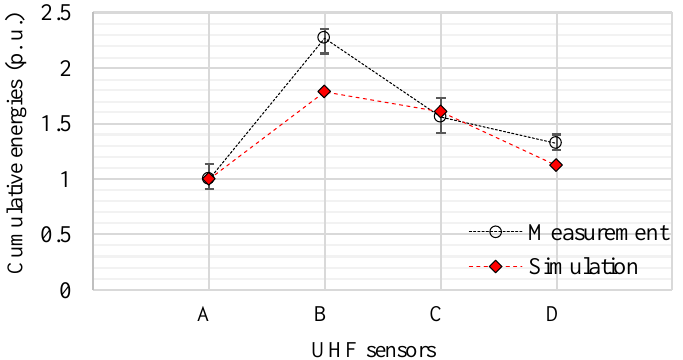
Figure 8. Examples of the simulated and measured EM waveforms by sensor A.